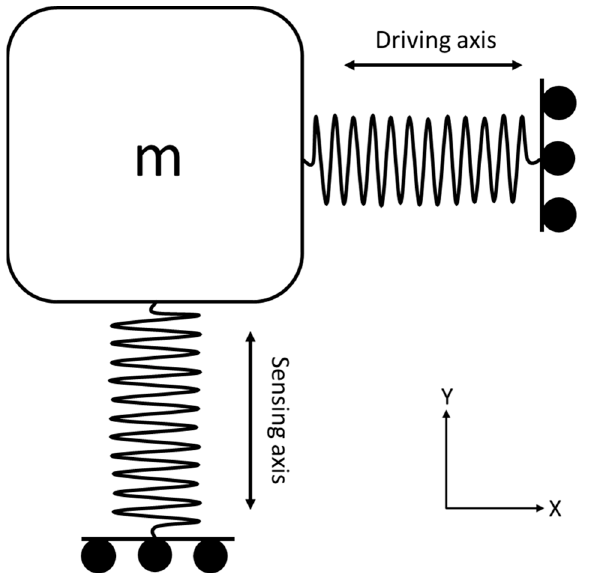
Figure 1. A schematic diagram of a simple proof mass of two degrees of freedom.